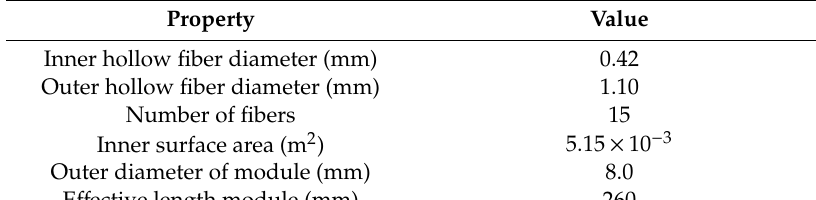
Table 1. Dimensions membrane module [1].